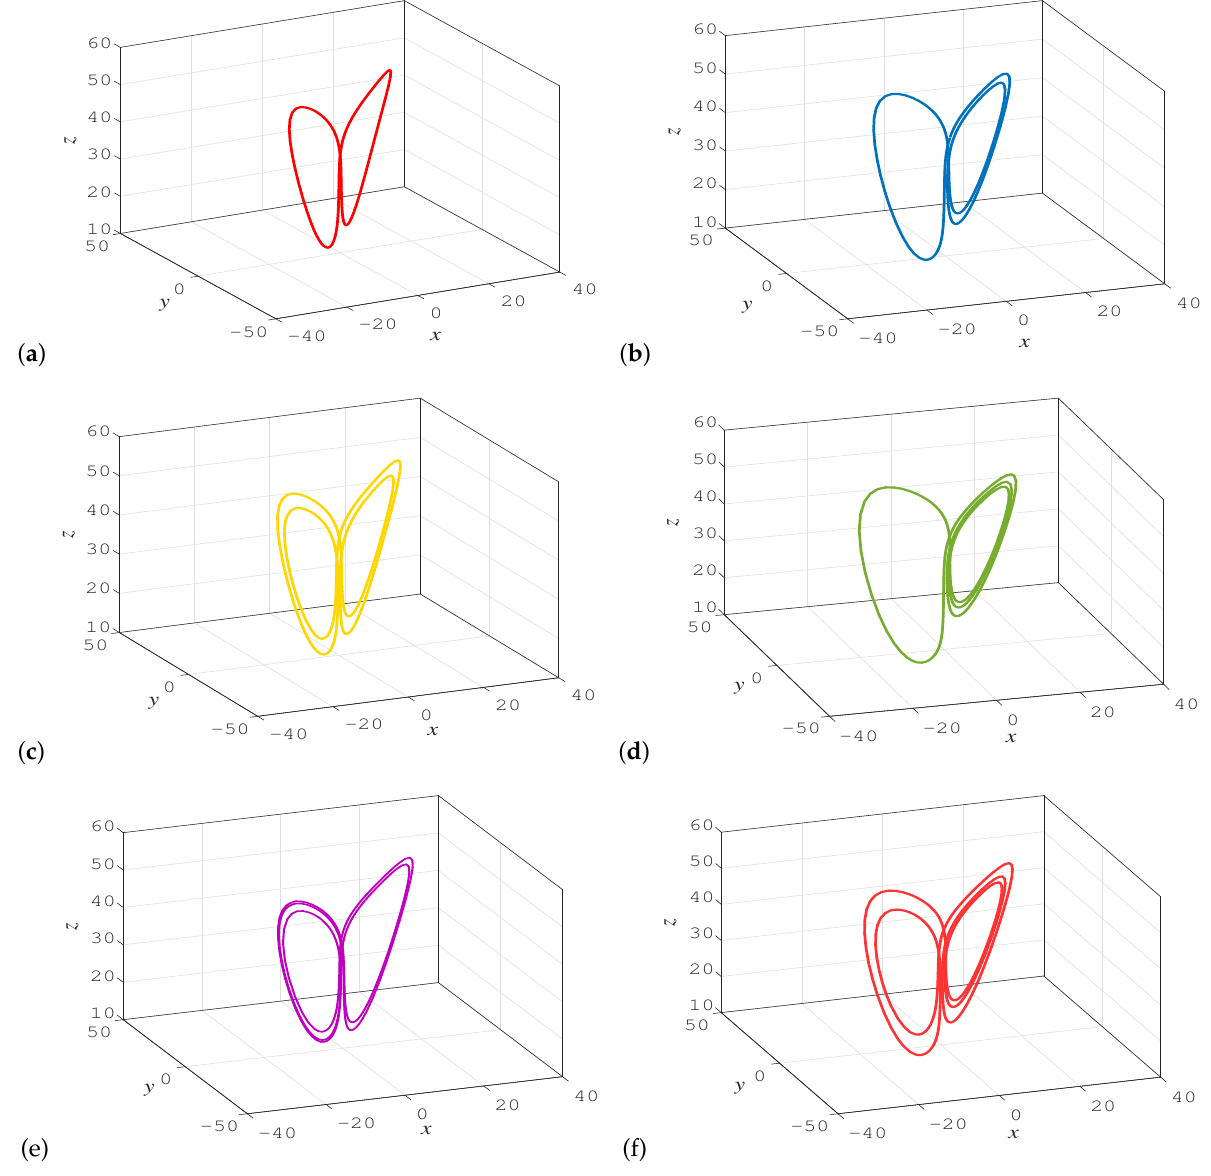
Figure 14. Unstable cycles in system (2) under parameters ( a , b , c , d ) = ( 35,3,35,10 ) : Cycles ( a ) 01; ( b ) 011; ( c ) 0011; ( d ) 0111; (e) 00101; (f)